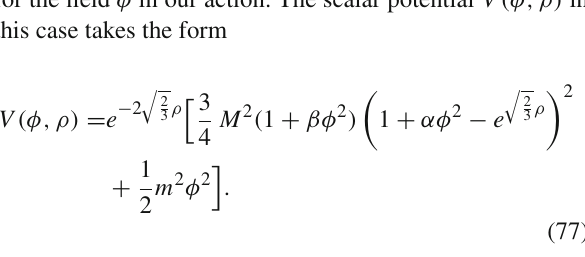
Fig. 5 Top: the running of slow-roll parameter (cid:12) . Bottom: the running of slow-roll parameter